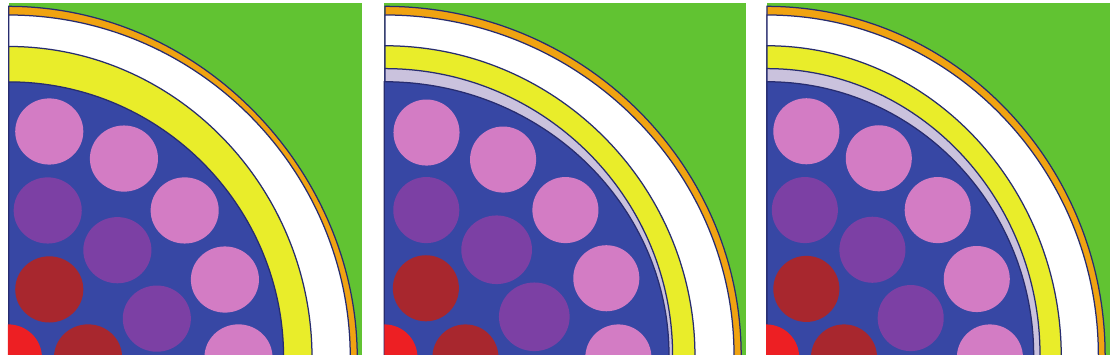
Figure 3: Enlargement of the geometry modeling.